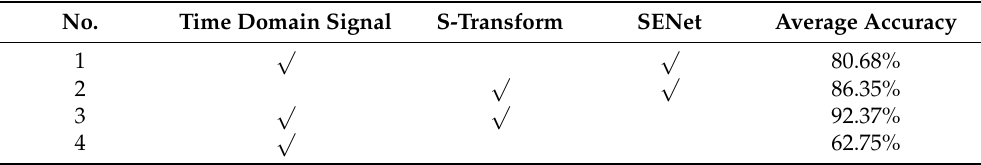
80.68% 86.35% 92.37%